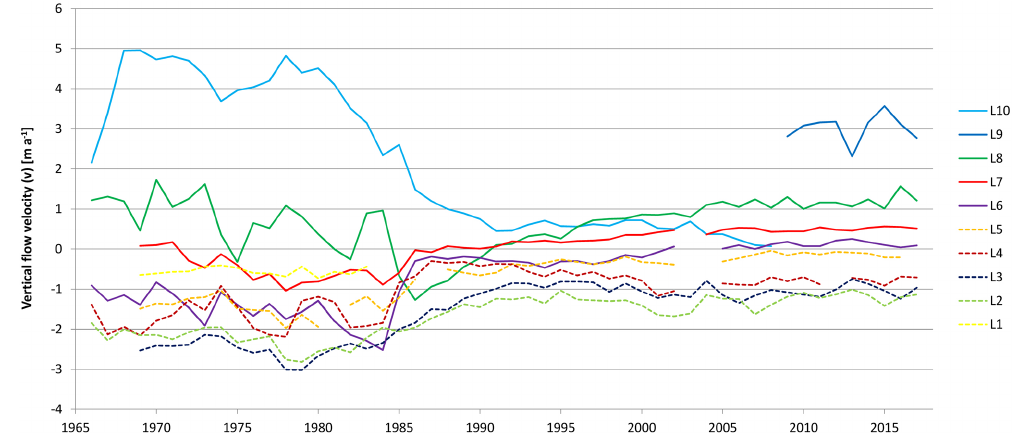
Figure 5. Annual vertical velocities ( (cid:49)v/a ) at the accumulation and ablation stakes on Kesselwandferner (e.g. the year 2015 refers to the hydrological year 2014/2015). Positive values represent emergence flow, negative ones represent submergence flow. Locations of the stakes are shown in Fig. 1.